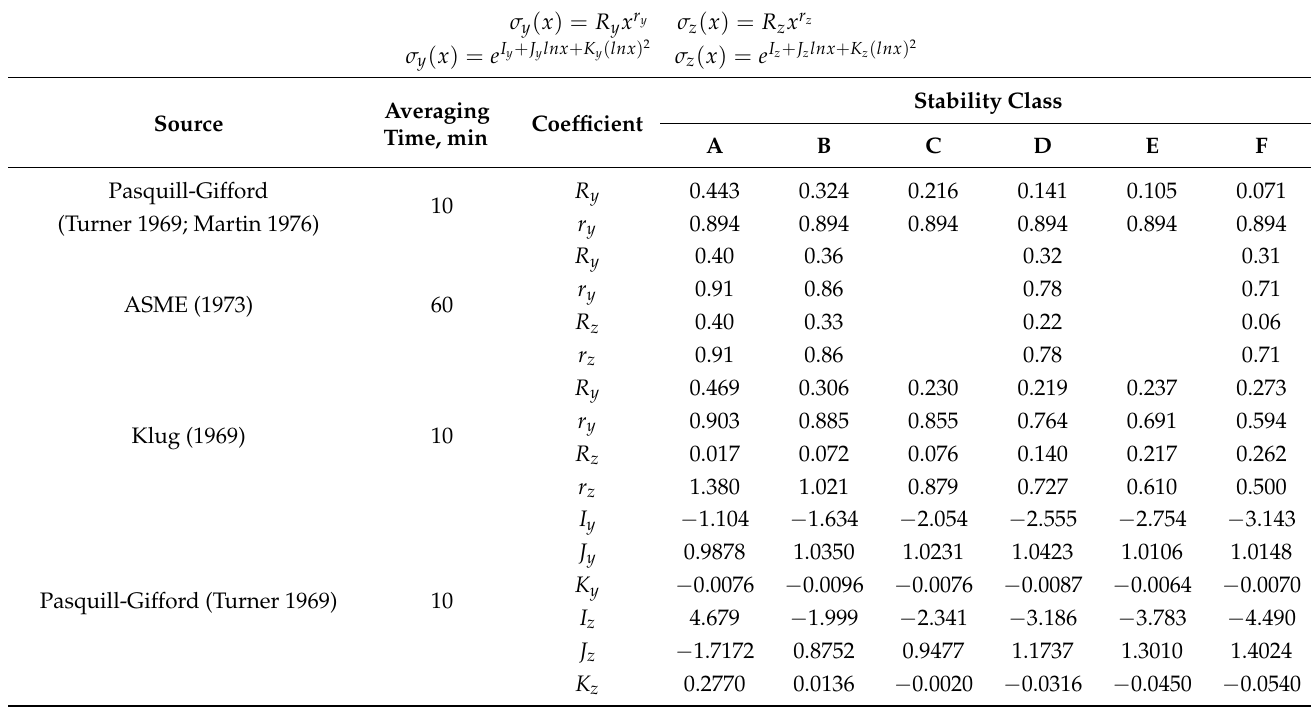
Table 5. Coefficients of the dispersion parameters by Gaussian plume